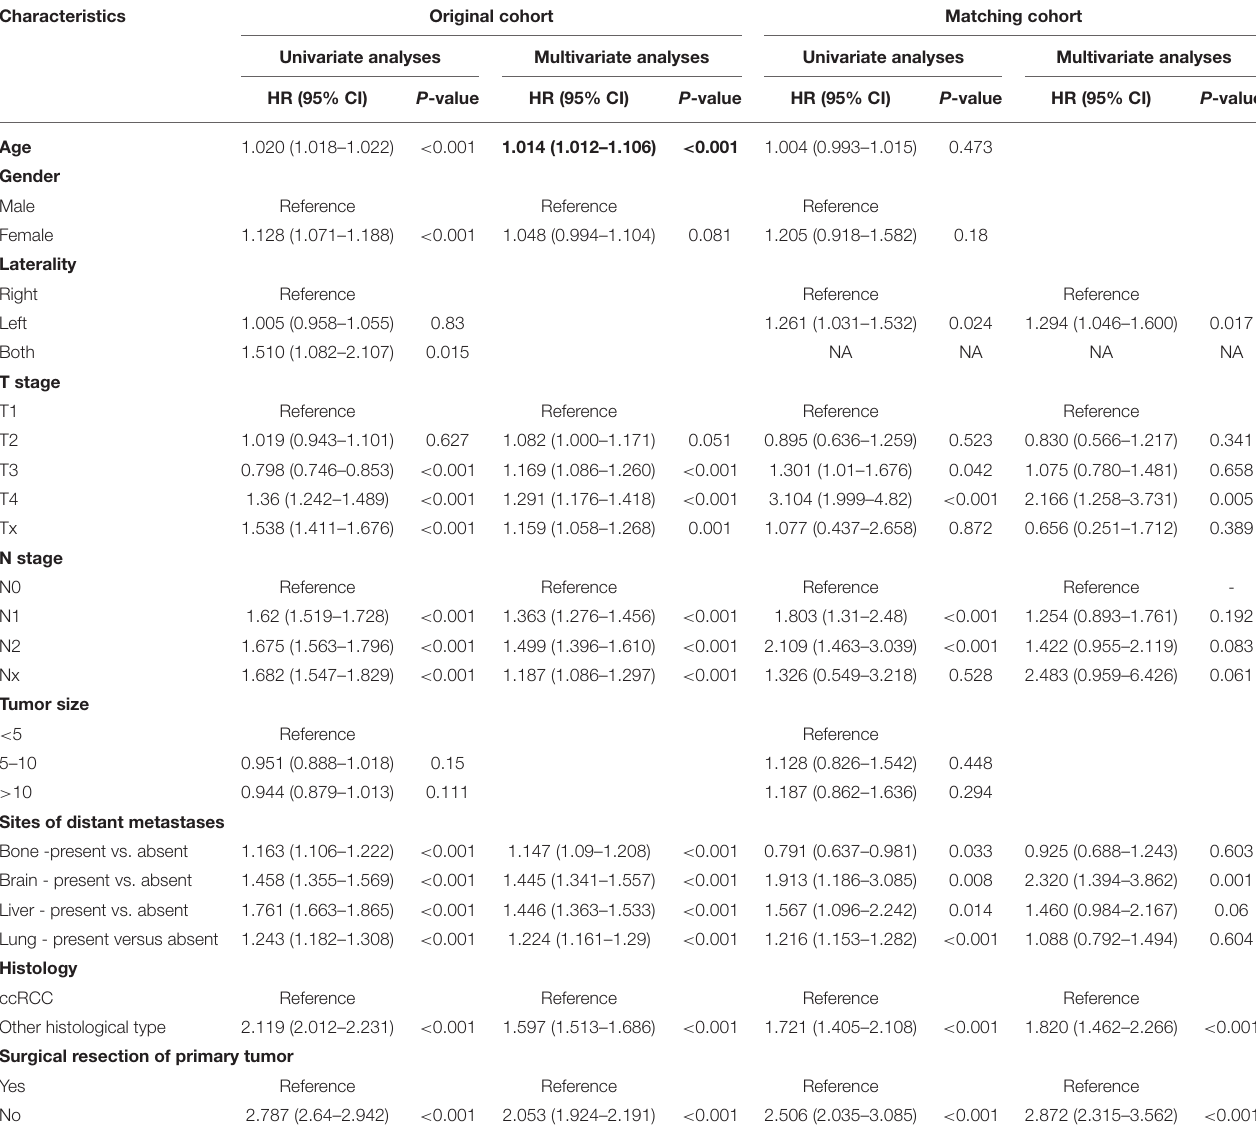
TABLE 3 | Univariate and multivariate analysis of prognostic factors influencing overall survival. Characteristics Original cohort Matching cohort Univariate analyses Multivariate analyses Univariate analyses Multivariate